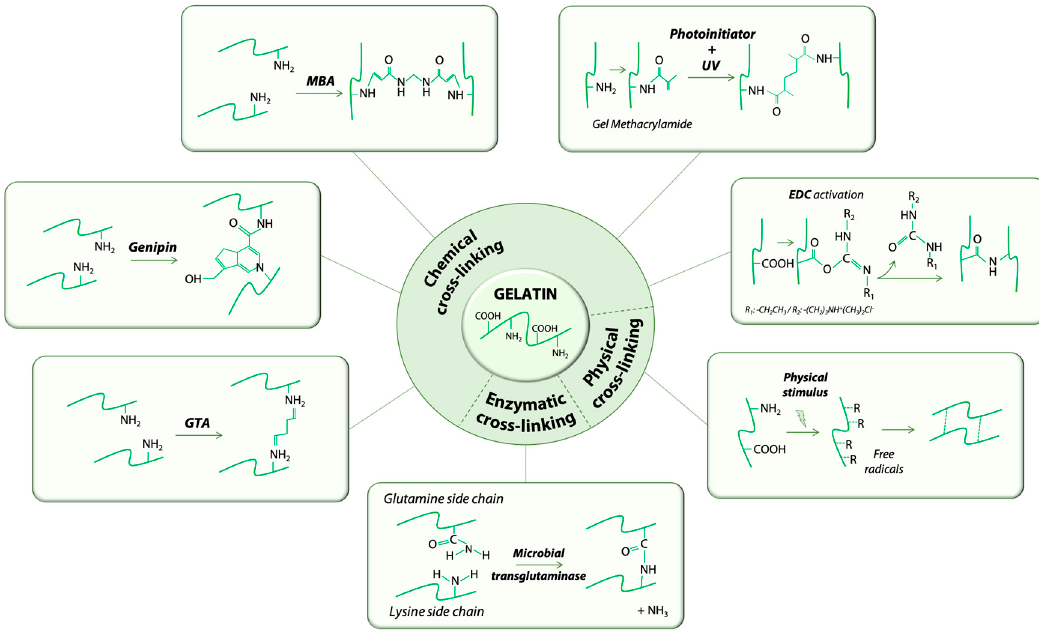
Figure 2. Schematic illustration of representative cross-linking methods used to fabricate gelatin hydrogels.